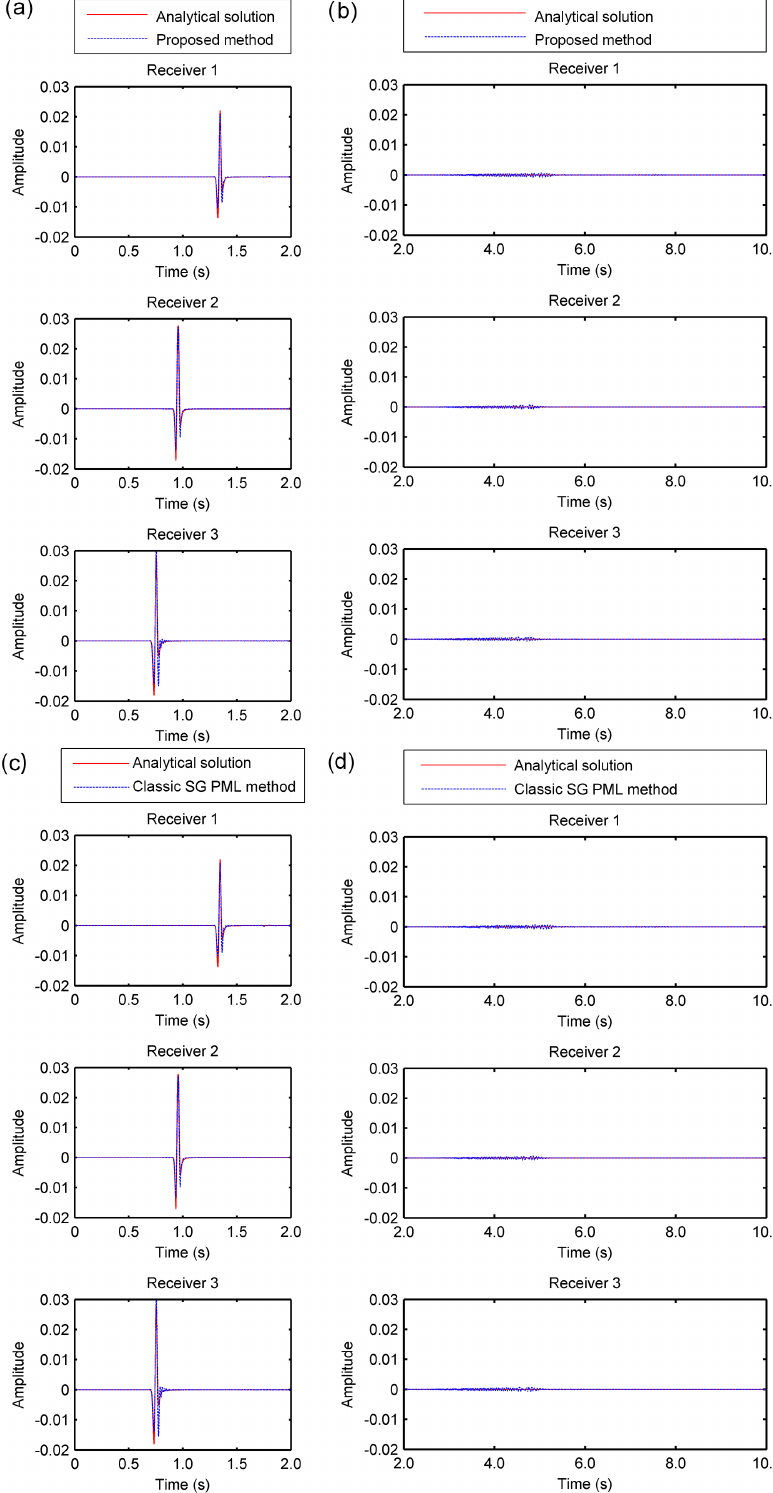
Figure 6. Comparison of the analytical solution (red solid line) with the proposed (fourth-order CG scheme) and classic SG PML methods (fourth-order SG scheme) (blue dotted line) at different receivers and d = 12m. (a) Proposed method at receivers 1, 2, and 3 during the first 2s; (b) proposed method at receivers 1, 2, and 3 after 2s; (c) classic SG PML method at receivers 1, 2, and 3 during the first 2s; (d) classic SG PML method at receivers 1, 2, and 3 after